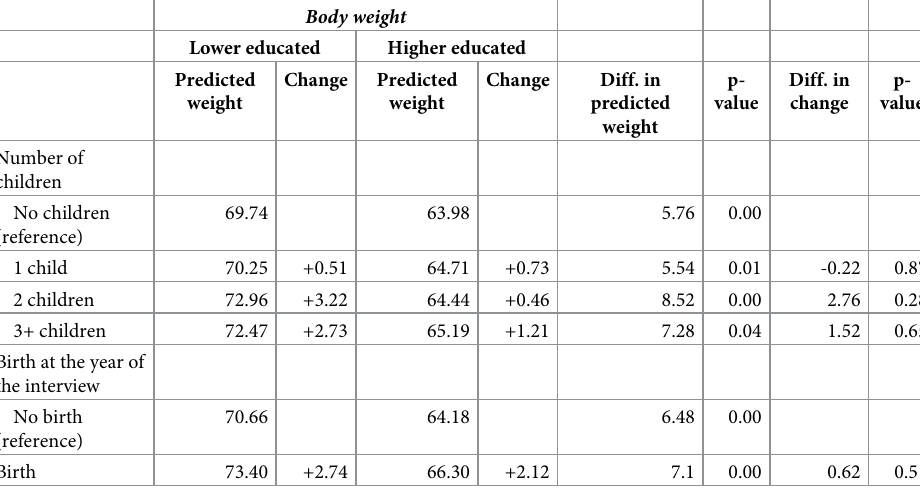
Table 3. Education differences in effects of motherhood on body weight at age